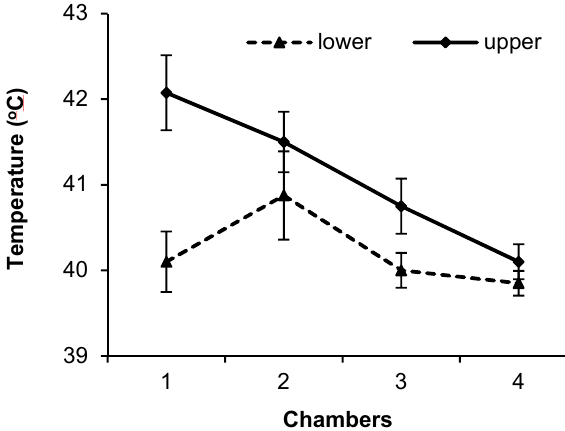
Figure 4. Mean (±SE) T box_max recorded in four black plywood boxes on 20 November 2015 when the ambient temperature reached a maximum of 39.5 °C. Loggers were placed in each of the four chambers at an upper and lower position (15 cm and 45 cm from top respectively). 1 = front chamber; 2 = second chamber; 3 = third chamber; 4 = back chamber.